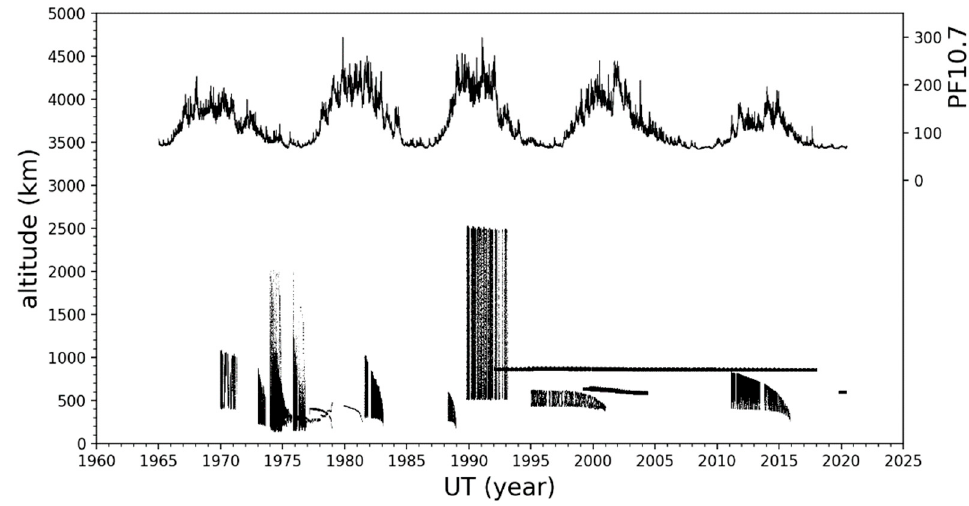
Figure 1. Year–altitude coverage of data in the database for individual satellite missions and corre- sponding 81-day running mean of the F10.7 index.